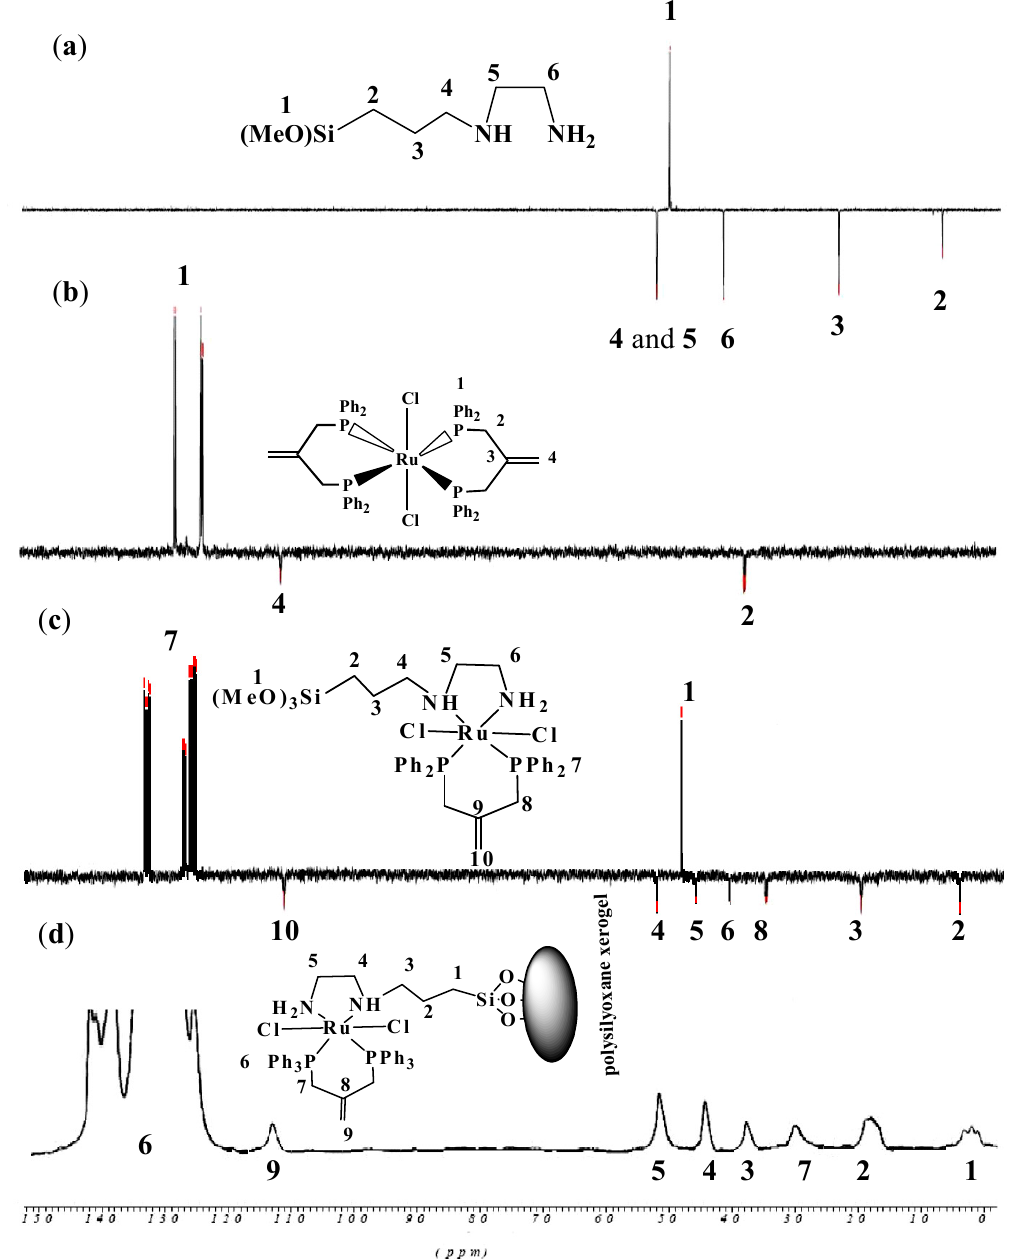
Figure 6. Dept 135 13 C-NMR: ( a ) free [3-(2-aminoethyl)aminopropyl]trimethoxysilane, ( b ) (dppme) ], ( c ) complex 1 , ( d ) solid state 13 C-CP-MAS-NMR X1 [RuCl 2 2